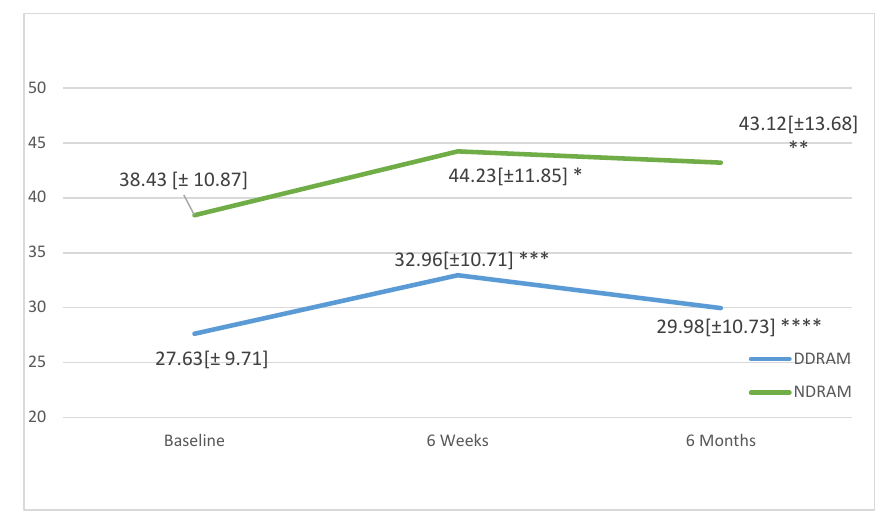
Figure 4. Changes in mental health as measured with the SF-12 in patients in each study group throughout the follow-up. Values expressed in means and standard deviations. p -values calculated with paired Student’s t -test. * p = 0.137, ** p = 0.049, *** p = 0.185, **** p = 0.329. The rates of clinical complications did not differ significantly between the groups (chi 2 p = 0.120).